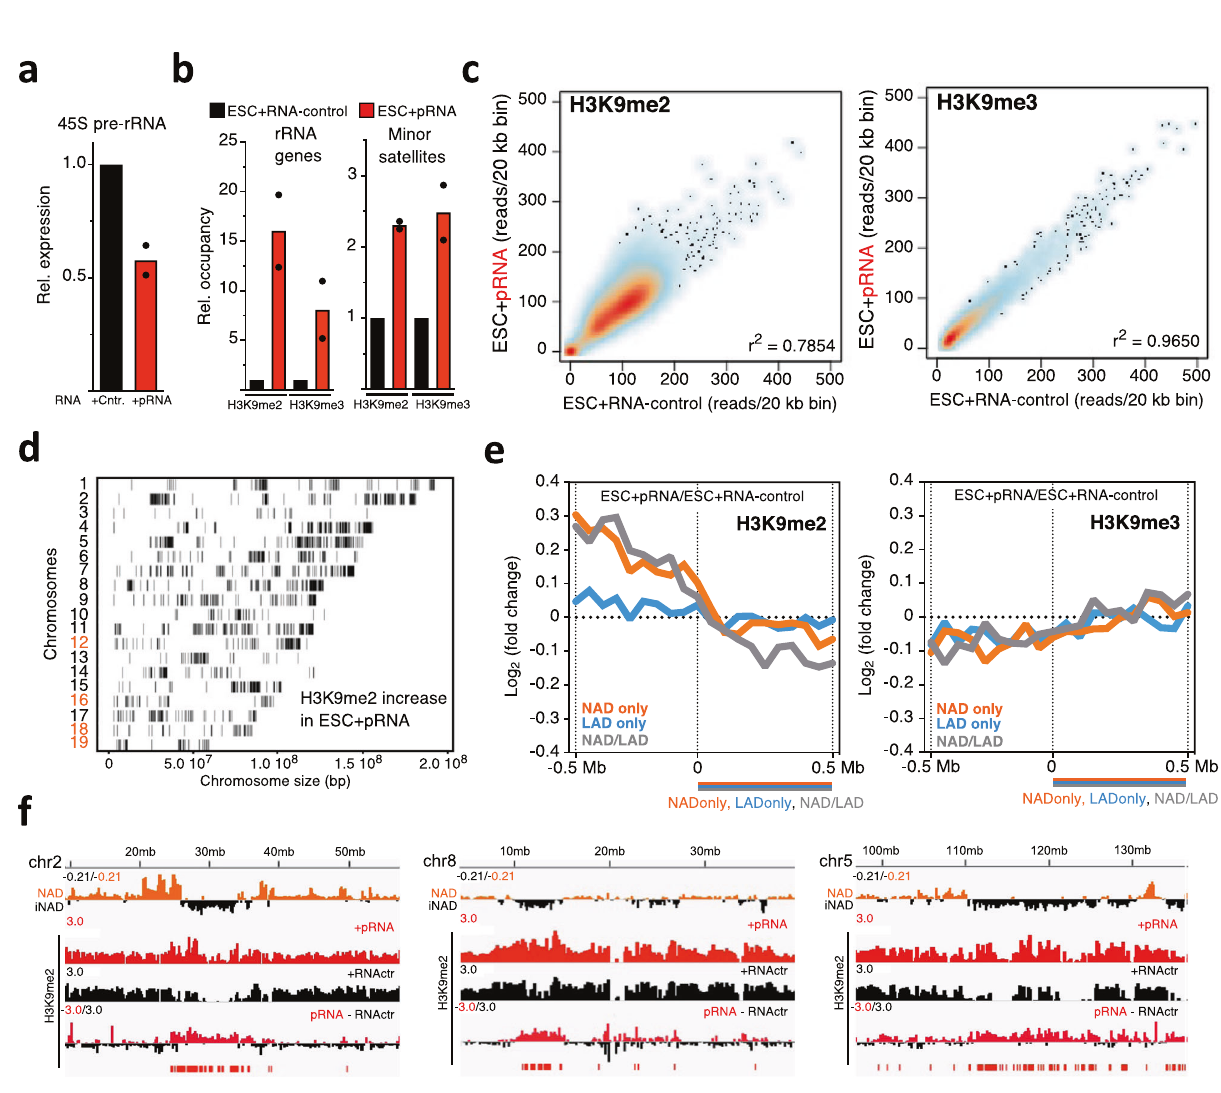
Fig. 4 The chromatin state of rRNA genes regulates H3K9me2 levels at sequences adjacent to the nucleolus. a qRT-PCR showing 45 S pre-rRNA levels in ESCs transfected with pRNA or RNA-control. Values were normalized to β -actin mRNA and to ESCs transfected with RNA-control. Data are from two independent experiments. b H3K9me2 and H3K9me3 ChIP in ESCs transfected with pRNA or RNA-control. Data were measured by qPCR and normalized to input and ESC + RNA-control. Data are from two independent experiments. c Addition of pRNA in ESCs caused an increase in H3K9me2 at several genomic regions. Scatter plot showing H3K9me2 and H3K9me3 levels (reads/20kb bin) between ESC + pRNA and ESC + RNA-control. d Chromosomal interaction map showing the distribution of regions with increased H3K9me2 levels in ESC + pRNA compared to ESC + RNA-control. e Heterochromatinization of rRNA genes promotes H3K9me2 expansion at regions neighboring NADs. H3K9me2 fold changes in ESC + pRNA vs. ESC + RNA-control plotted over the boundaries of NAD-only, LAD-only, and NAD/LAD. f Representative images showing the increase of H3K9me2 at regions neighboring NADs. Source data are provided as a Source Data fi